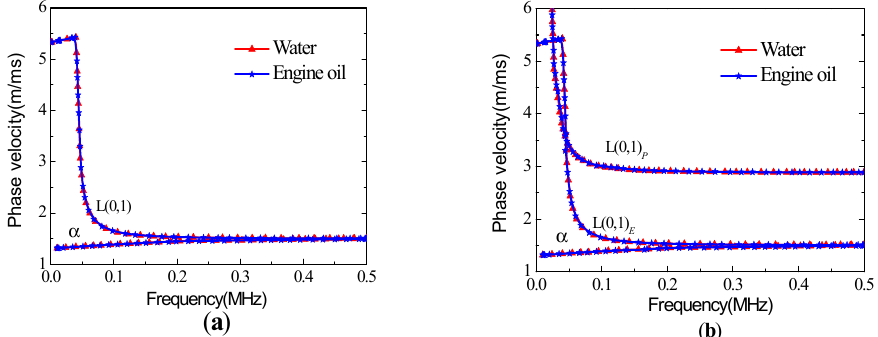
Figure 6. Dispersion curves of guided waves in water-filled pipe embedded in ( a ) infinite porous medium, and ( b ) finite porous medium. The thickness of the finite porous medium is d = 0.05 m. Porosity is β = 0.1. Red and blue lines represent the different pore fluids of water and engine oil,